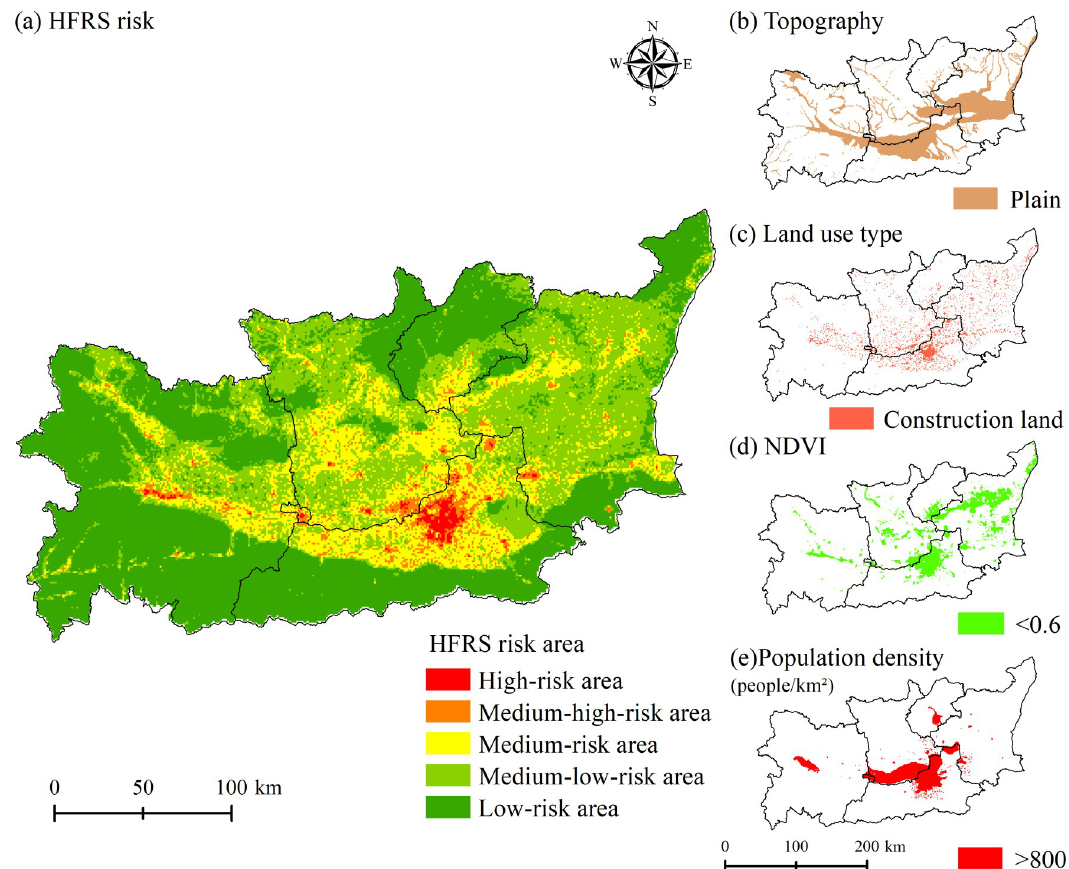
Fig 7. Potential risk area of HFRS epidemic and spatial distribution of major environmental factors in 2015. https://www.resdc. cn/Datalist1.aspx?FieldTyepID=20,0. https://doi.org/10.1371/journal.pntd.0011245.g007 distributed in areas with low vegetation cover and dense population distribution, and land use was mostly construction land and cultivated land. The high-risk area and medium-high-risk area were superimposed areas of the risk thresholds of the main influencing factors of topogra- phy, land use, NDVI, and population density, and this characteristic became more obvious over time. The results showed that although the high-risk area and the medium-high-risk area accounted for a relatively small area, the potential HFRS epidemic risk was very high,